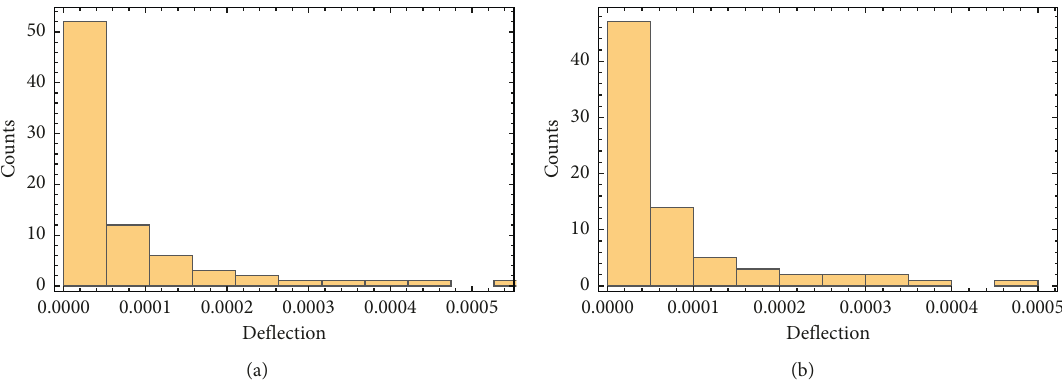
Figure 10: Frequency response distribution: Transverse deflections over the combined sparse grids X GL and X CC . (a) Frequency � 65Hz. (b) Frequency � 85Hz.